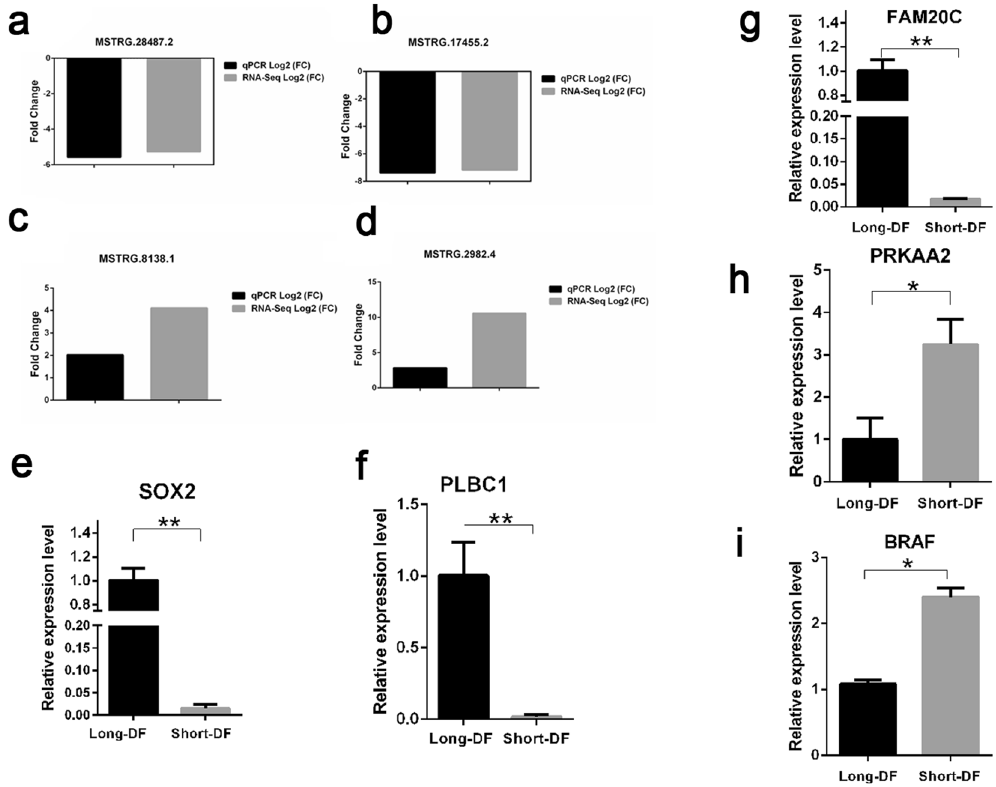
Figure 8. Validation of differentially expressed lncRNAs by qPCR. ( a , b ) Fold change expression of down- regulated lncRNAs in long DF hens compared with the short DF hens; ( c , d ) Fold change expression of up- regulated lncRNAs in long DF hens compared with short DF hens. Data are reported for three technical replicates in all biological samples. ( e – i ) The expression levels of lncRNA target genes between long and short DF hens. Each histogram represents the level of the target gene relative expression level. Error bars indicate standard error of the mean (SEM). Asterisks symbolized P-value significance * p ≤ 0.05, and ** p ≤ 0.01, based on assuming unequal variances Student’s